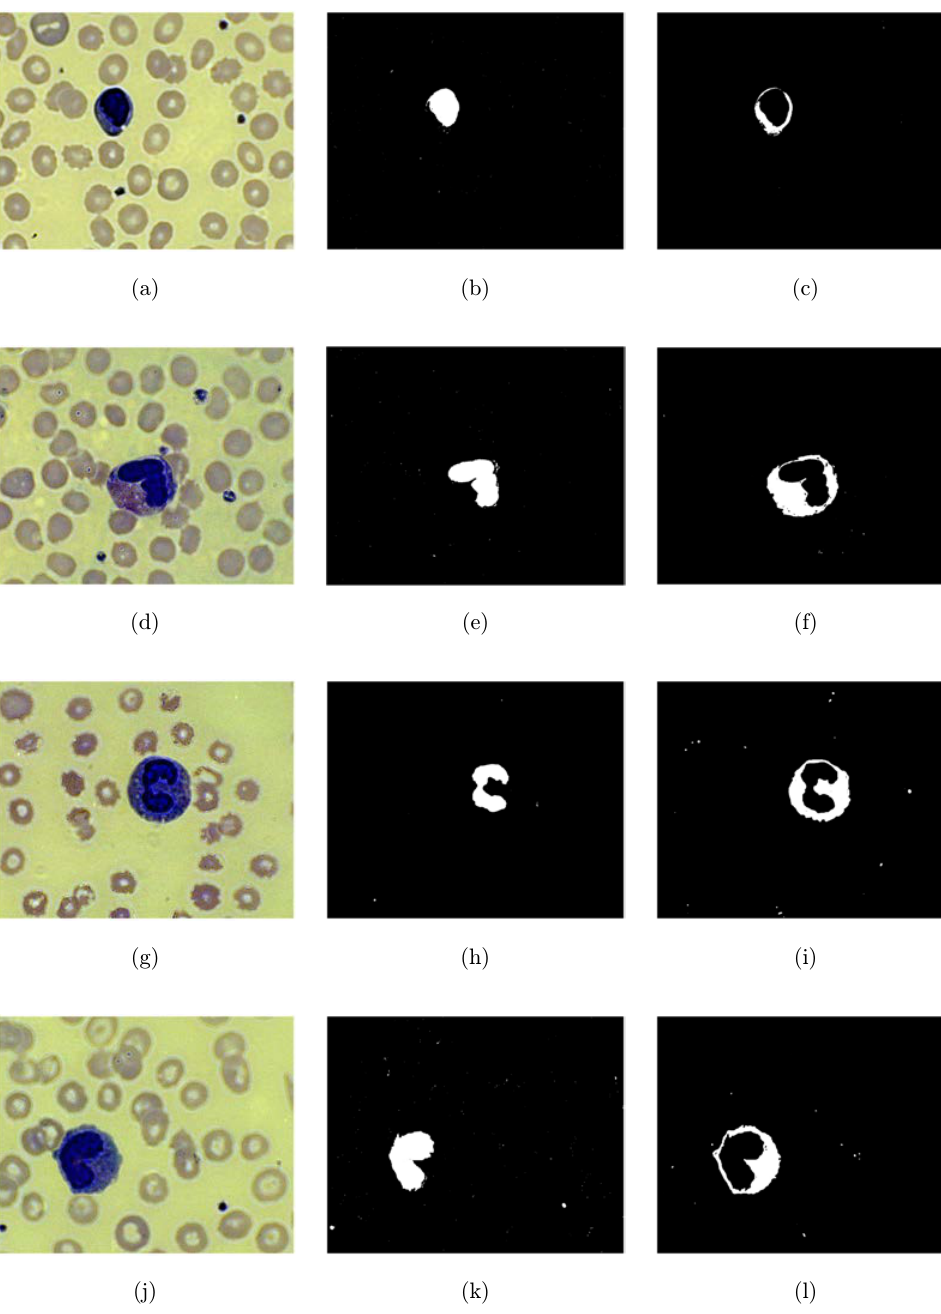
Fig. 6. (a), (d), (g), (j), (m) and (p) Hyperspectral images of lymphocyte, eosinophil, neutrophil, monocyte basophil and lymphoblast; (b), (e), (h), (k), (n) and (q) Binary images of the corresponding nucleus; (c), (f), (i), (l), (o) and (r) Binary images of the corresponding